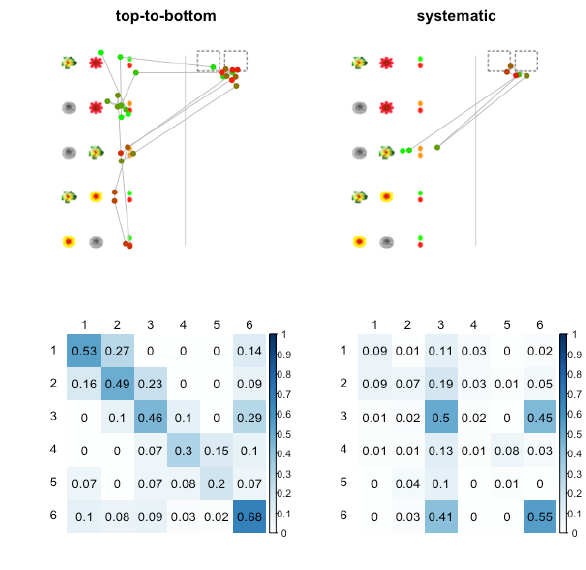
Figure 1. Synthetic data of two strategies in one of the selected Mastermind games. The left panel shows the top-to-bottom strat- egy, and the right panel shows the systematic strategy of selective processing. The top panel shows examples of the scanpaths, where dots correspond to fixations (the color gradually changes from bright green to dark red based on the order of the fixations) and lines connect the successive fixations (i.e., saccades). Bottom panel shows the transition matrices of the simulated strategies over 1,000